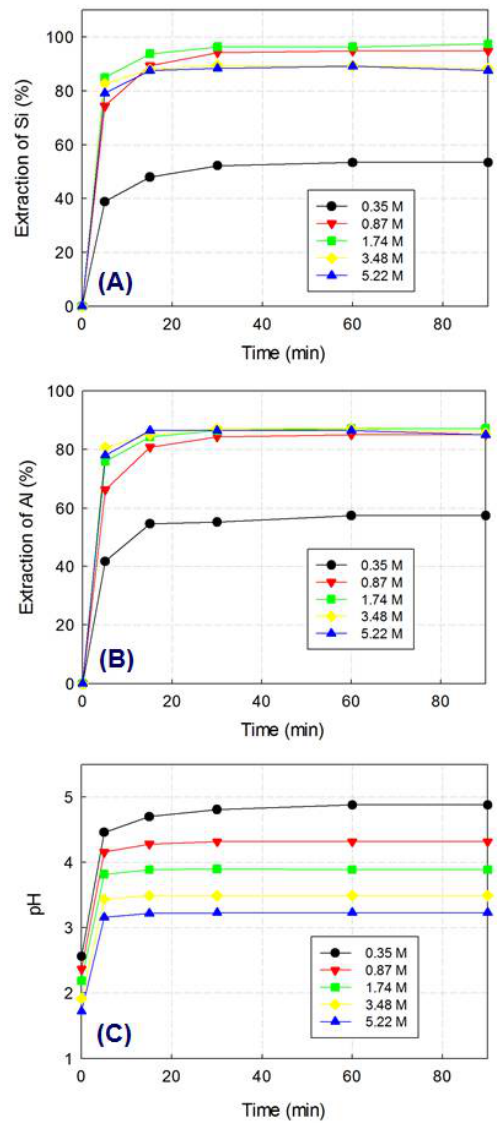
Figure 1. The changes in leaching efficiencies of ( A ) Si and ( B ) Al and ( C ) pH observed as a function of acetic acid concentration.